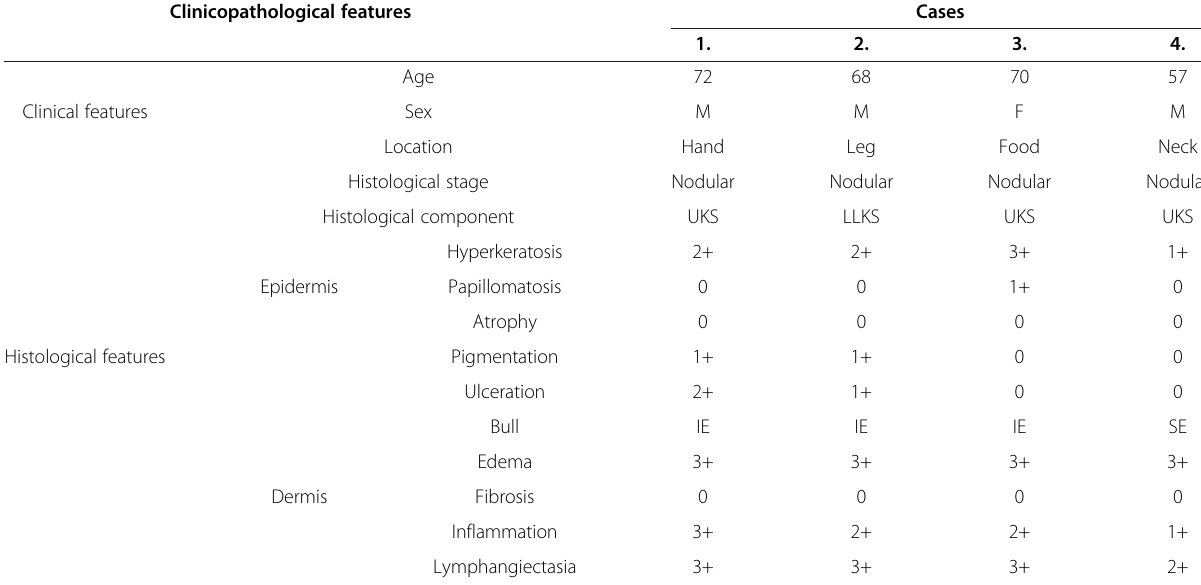
Table 2 Clinicopathological features of Kaposi sarcoma cases showing bullous morphology (n =4) Clinicopathological features